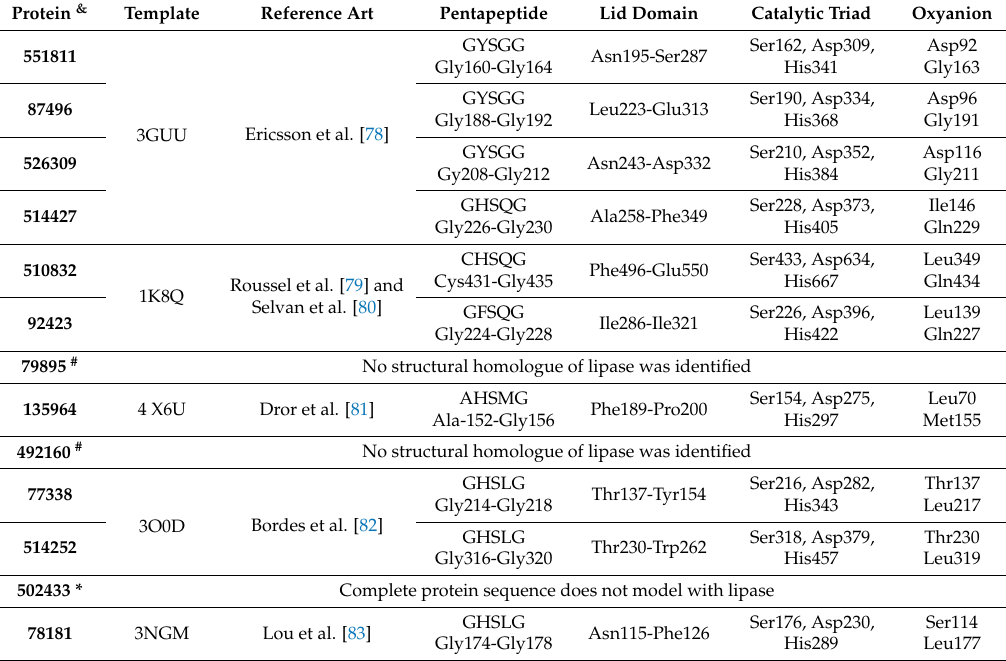
Table 4. In silico localization of characteristic lipase domains in the candidate lipase proteins from Trichoderma harzianum